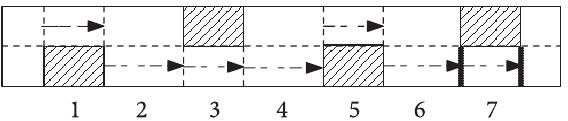
Fig. 7 . An example of fi lling of construction works corridor for the travel in a sequential mode